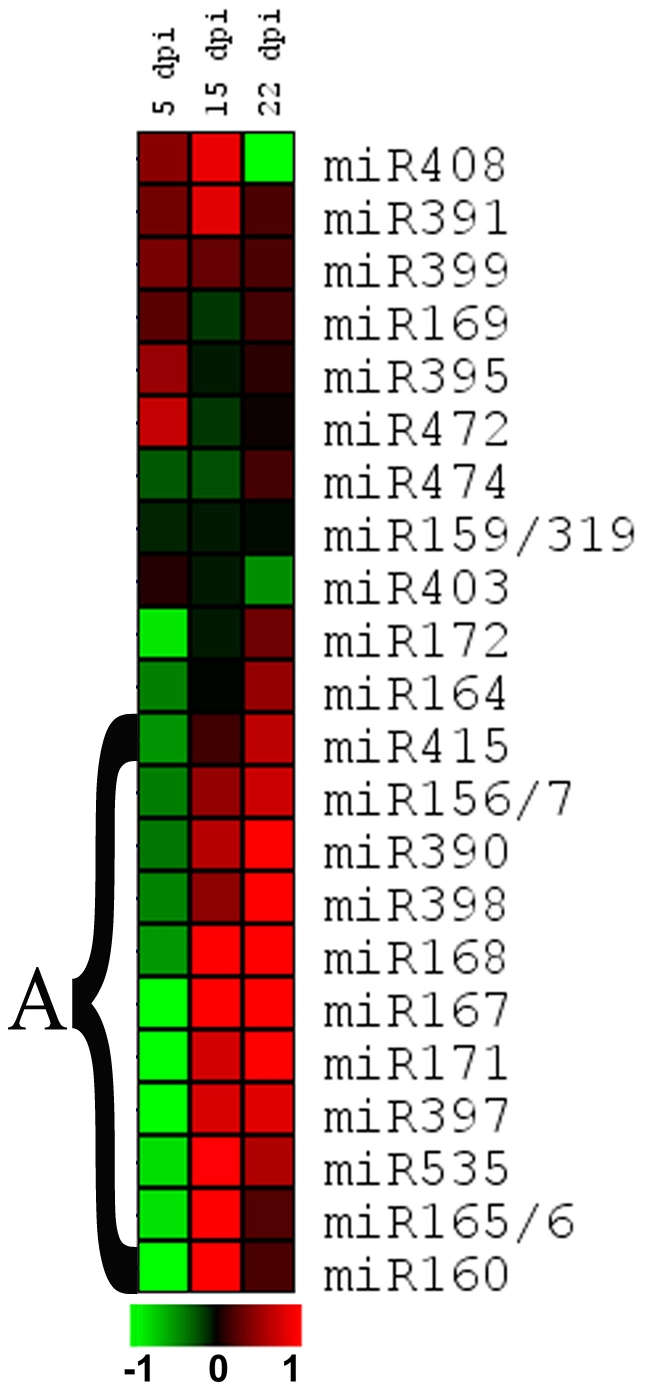
Temporal profiling of miRNAs accumulation following TMV infection.Systemic, non-inoculated tobacco leaves were sampled from virus- and mock-inoculated plants (n = 6 for each day and treatment) at 5, 15 and 22 dpi. miRNAs accumulation in TMV-inoculated plants were compared to those corresponding to mock-inoculated plants and the relative accumulation was calculated as the ratio between virus- and mock-inoculated samples at each time point. These ratios were log2 transformed and further analyzed with hierarchical clustering with average linkage. False-color scale indicates lower (green) or greater (red) miRNA accumulation in TMV-infected plants respect to mock-inoculated ones. The horizontal bar shows the log2-based scale. See Materials and Methods for further details.